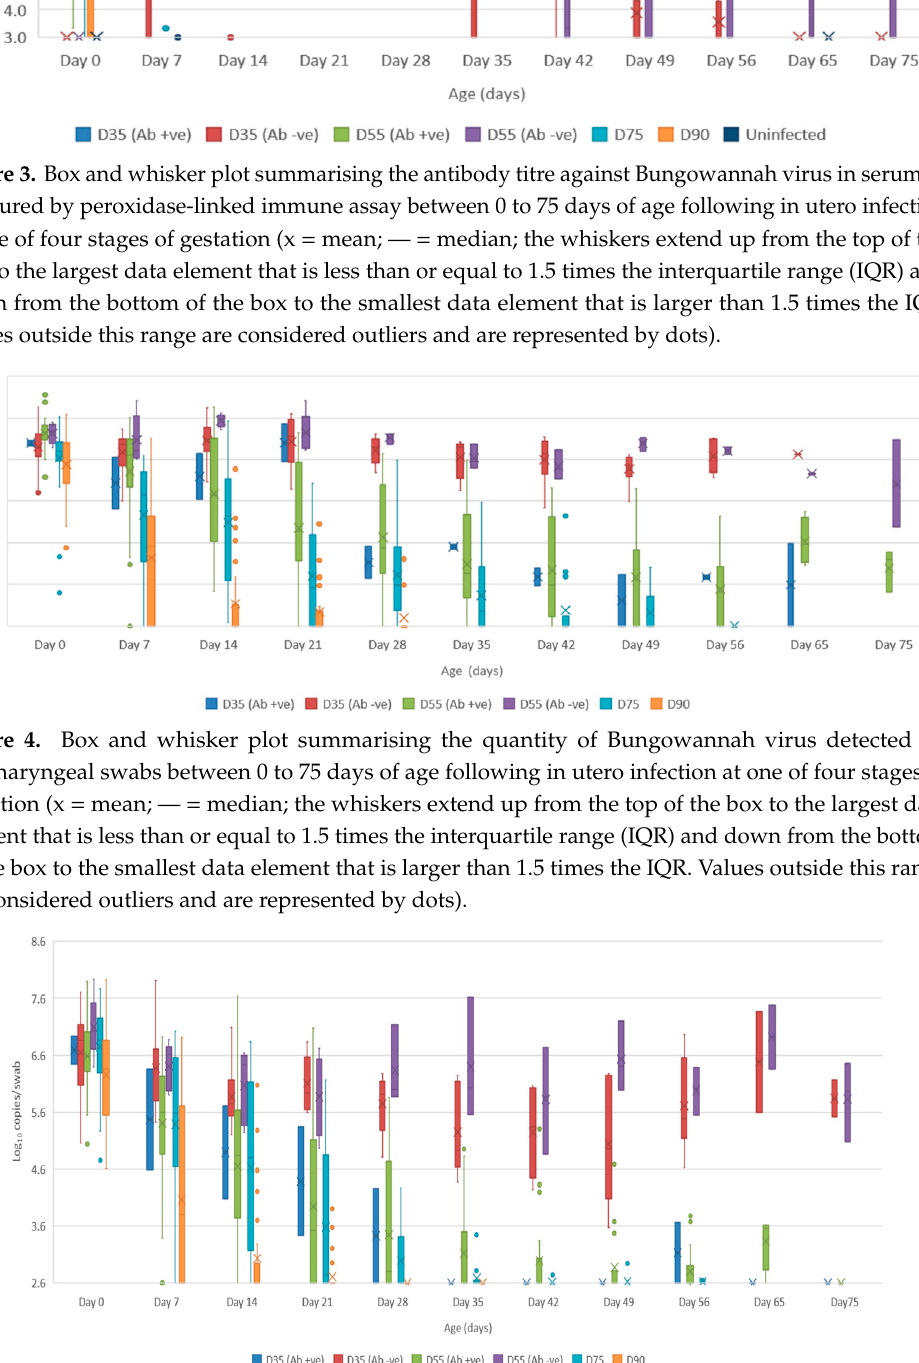
Figure 5. Box and whisker plot summarising the quantity of Bungowannah virus detected on rectal swabs between 0 to 75 days of age following in utero infection at one of four stages of gestation (x = mean; — = median; the whiskers extend up from the top of the box to the largest data element that is less than or equal to 1.5 times the interquartile range (IQR) and down from the bottom of the box to the smallest data element that is larger than 1.5 times the IQR. Values outside this range are considered outliers and are represented by dots).